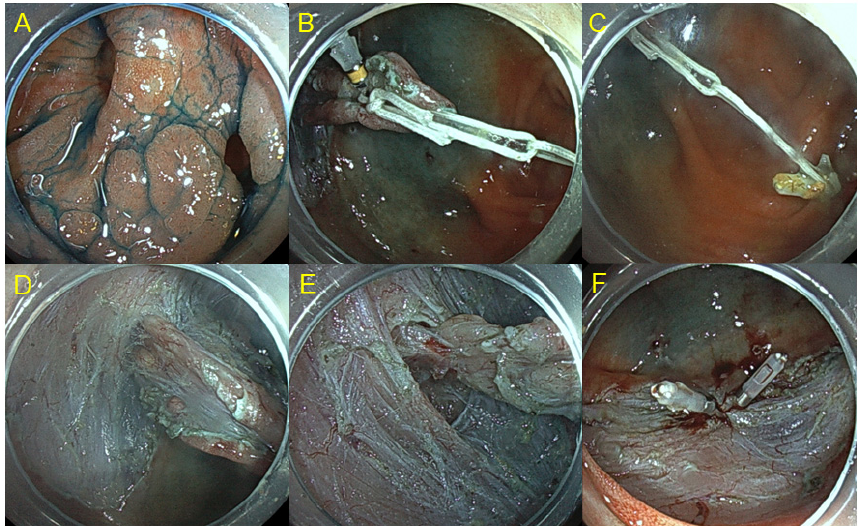
Figure 2. Colorectal ESD using clip-with loops method. ( A ) Laterally spreading tumor with a diver- ticulum in the cecum. ( B ) Clip with 2 loops was anchored to the lesion. ( C ) Another clip was attached to the opposite side of the lumen while hooking the loop. ( D ) Insufflation of CO2 enhances counter traction. ( E ) Submucosal dissection in the diverticulum. ( F ) En bloc resection was performed with- out any complication.